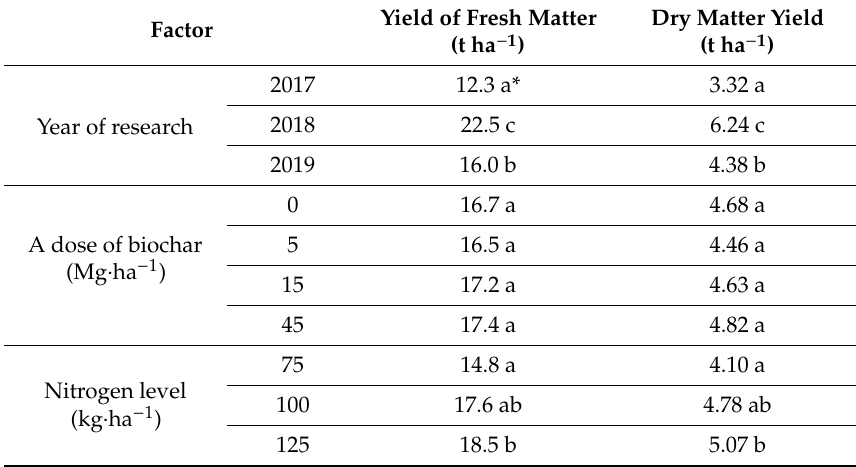
Table 2. Yield of fresh and dry matter (t ha − 1 ) of peppermint herb in 2017–2019. Yield of Fresh Factor